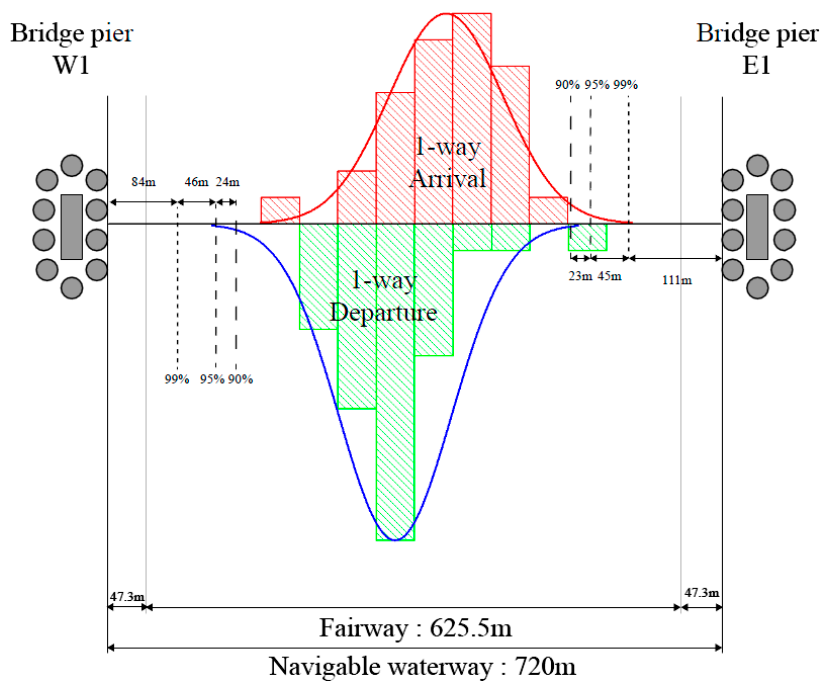
Figure 13. Traffic distribution at the Incheon bridge for 1-way traffic.